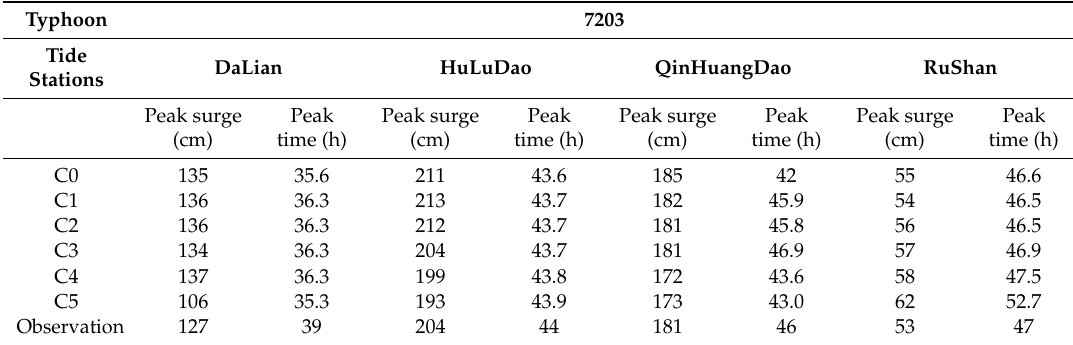
Table 4. The peak surge and peak time between simulation and observation of storm surge levels at four tide stations during Typhoon 7203.